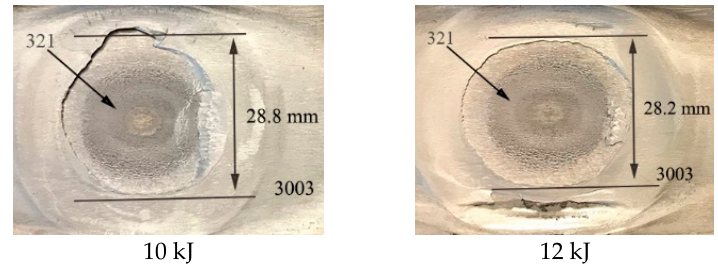
Figure 6. Lap-shear tested samples failed area at 6 kJ, 8 kJ, 10 kJ, and 12 kJ input energies.